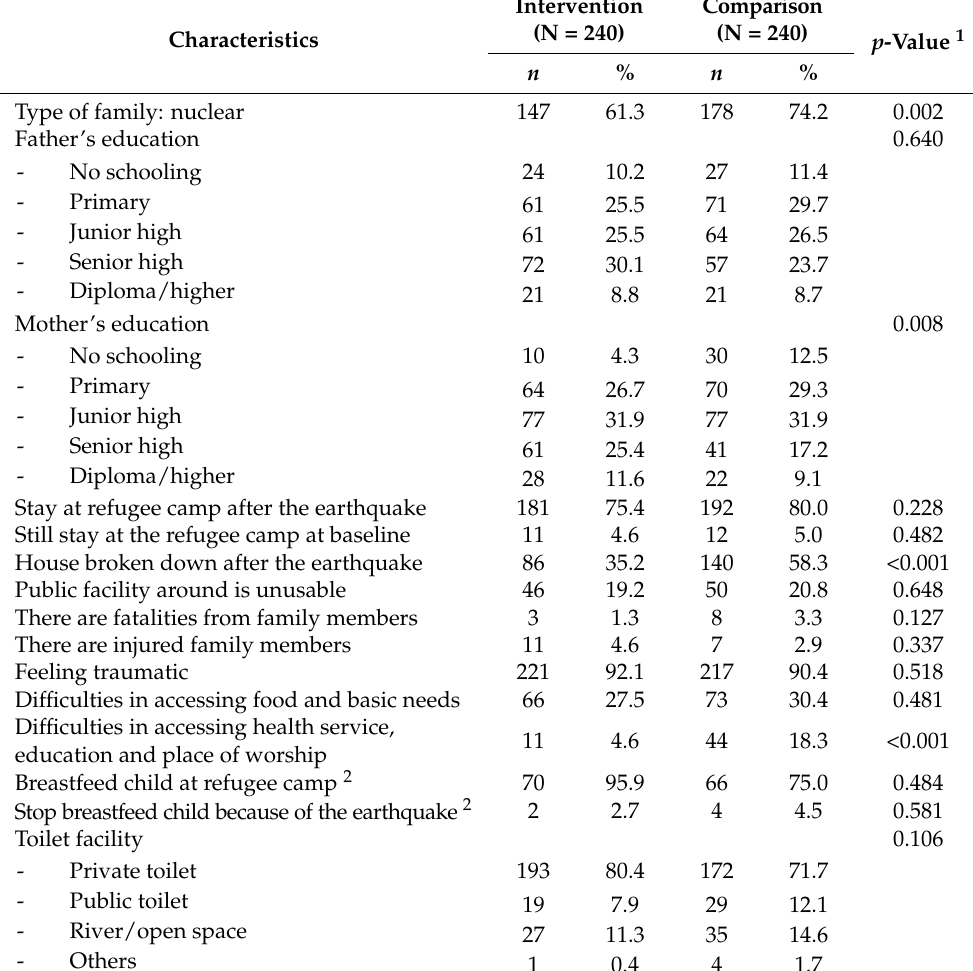
Table 1. Socio-demography characteristics of study subjects, by treatment group.